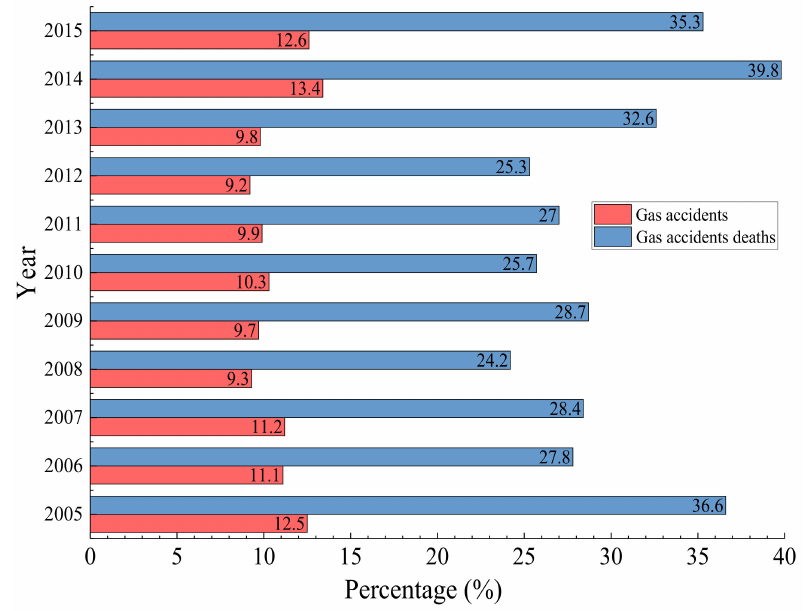
Figure 1. CBM-induced accidents from 2005 to